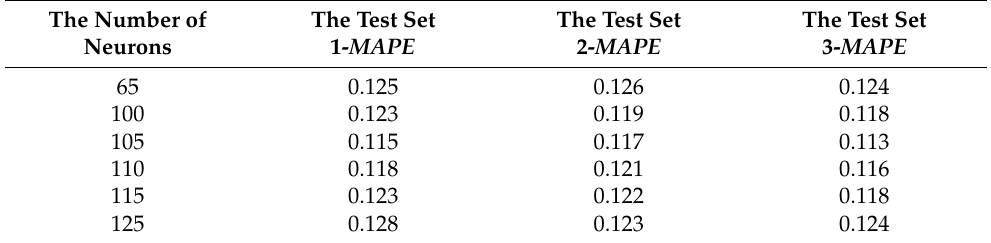
Table 4. The effect of the number of nodes in the hidden layer on the prediction effect of the model. The Number of